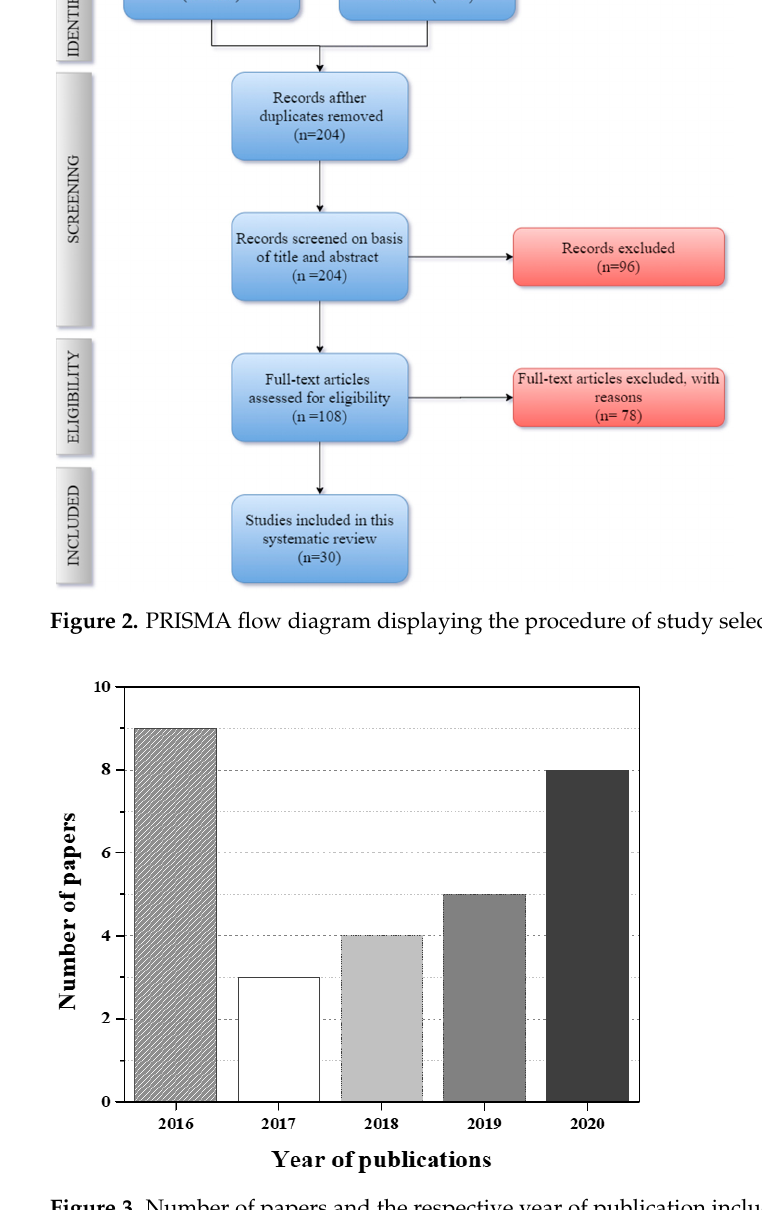
Figure 3. Number of papers and the respective year of publication included in the SR.